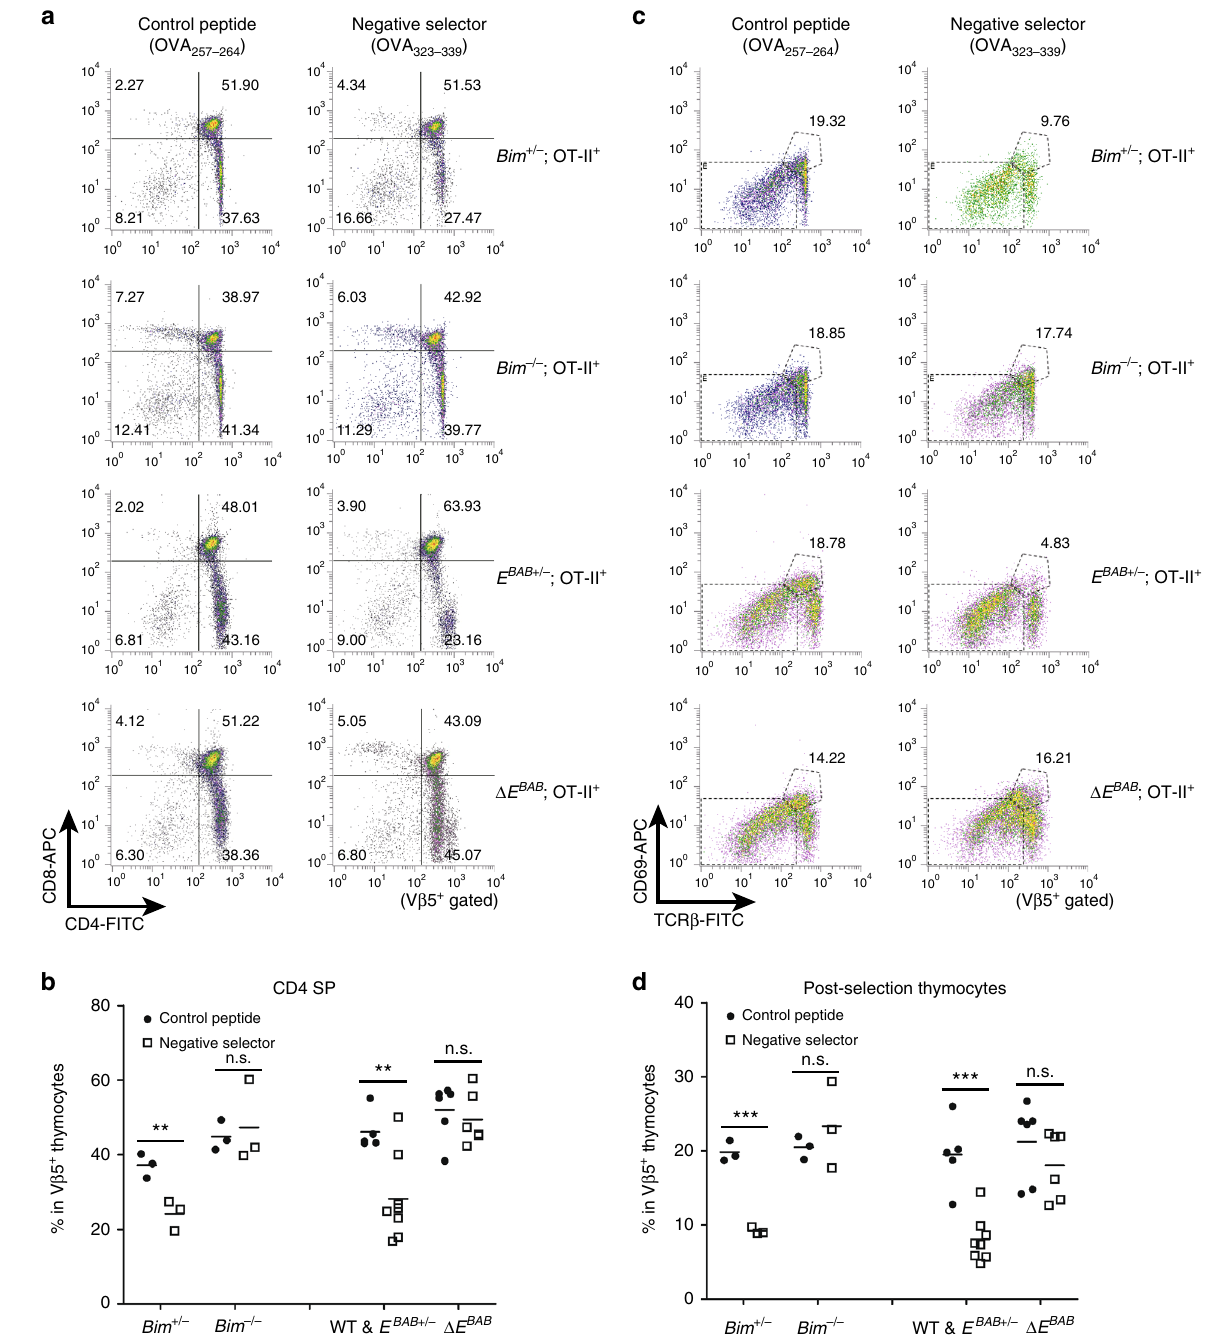
Fig. 4 E BAB is essential for depleting high af fi nity TCR clones in the OT-II tg model. a CD4 versus CD8 fl ow cytometric analysis of TCR V β 5 + thymocytes from mice injected with OVA 257 – 264 or OVA 323 – 229 peptide intraperitoneally. The number in the plot is representative percentage of each gate. b CD4 SP thymocyte proportion of TCR V β 5 + thymocytes from mice treated as in Fig. 4a. c TCR β versus CD69 fl ow cytometric analysis of TCR V β 5 + thymocytes from mice treated as in Fig. 4a. The number in the plot is representative percentage of the gate. d Post-selection (TCR β high CD69 high ) thymocyte proportion of TCR V β 5 + thymocytes from mice treated as in Fig. 4a. Data are representative of ( a , c ) or pooled from ( b , d ) 13 independent experiments ( n = 5 WT and E BAB + / − mice injected with OVA n = 8 WT and E BAB + / − ; OT-II + mice injected with OVA n = 6 Δ E BAB ; OT-II + mice injected 257 – 264 peptide, 323 – 339 peptide, with OVA 257 – 264 and OVA 323 – 339 peptide, n = 3 Bim + / − ; OT-II + and Bim − / − ; OT-II + mice injected with each peptide, 5 – 14 weeks old). Each symbol ( b , d ) represents an individual mouse; small horizontal lines indicate the mean. n.s. not signi fi cant ( P ≥ 0.05); ** P < 0.01, *** P < 0.001 (unpaired one-tailed Student ’ s t test for Bim KO data, unpaired two-tailed Student ’ s t test for Δ E BAB data)